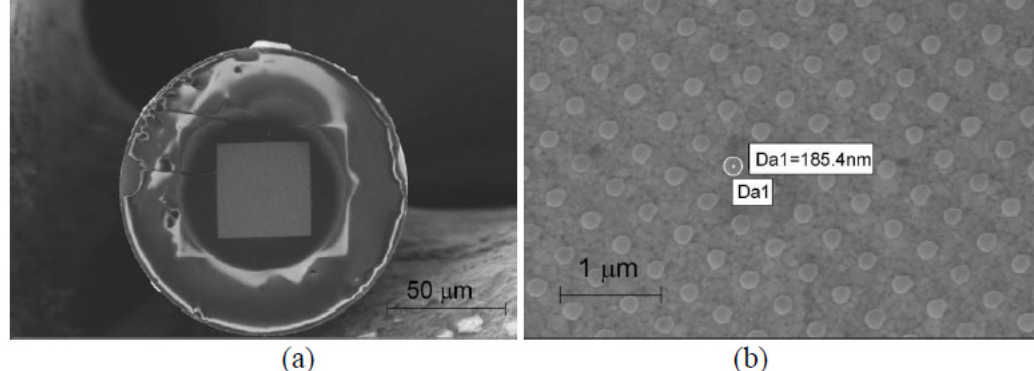
Figure 25. SEM images of a gold nanodot array on an optical fiber tip: ( a ) Overview of the optical fiber end facet; ( b ) Gold nanodot array on the optical fiber facet. Reprinted with permission of [89].